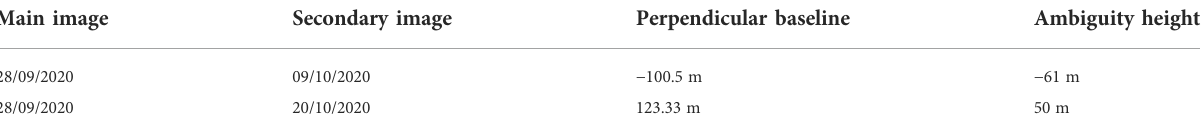
TABLE 1 Summary of the two interferometric con fi gurations. The ambiguity height is computed using the PAZ acquisition parameters: an altitude of 514 km, a mean incidence angle of 37.86 ° , and a wavelength of 3.1 cm. Main image